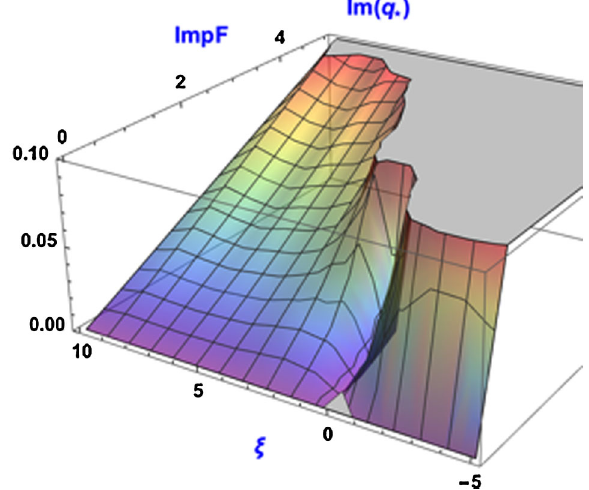
FIG. 14. The growth rate versus chromaticity and reactive gain for intensity twice exceeding zero-gain zero-chromaticity TMCI threshold, i.e. for ImpF ¼ 3 . 2 .